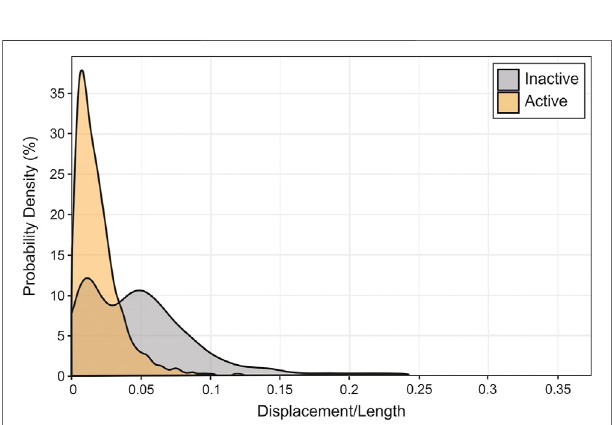
FIGURE 5 | Density estimates of the D/L value of active and inactive faults in our dataset. Peaks in the density plot are at the D/L values with the highest